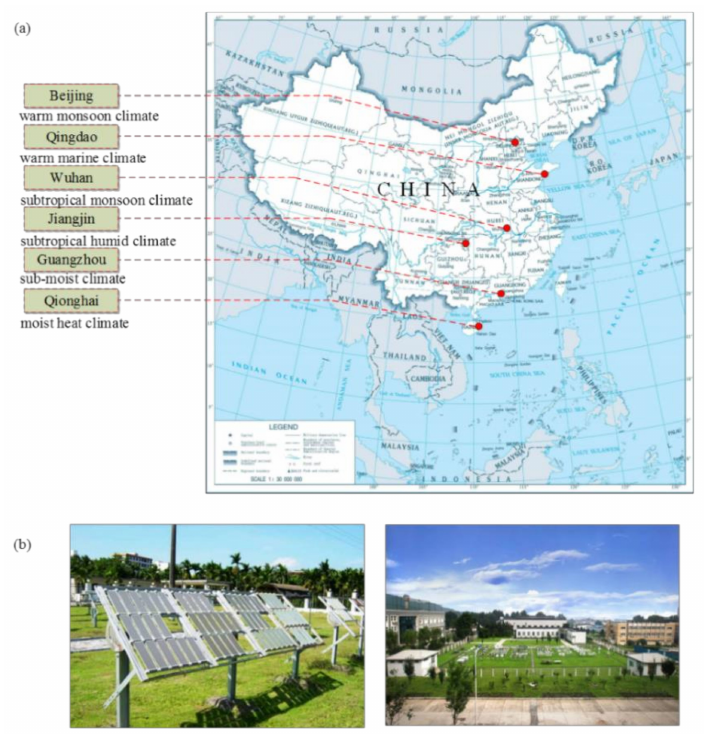
Figure 1. ( a ) The geographical distribution and climate types of 6 test stations; ( b ) the on-site pictures of exposure